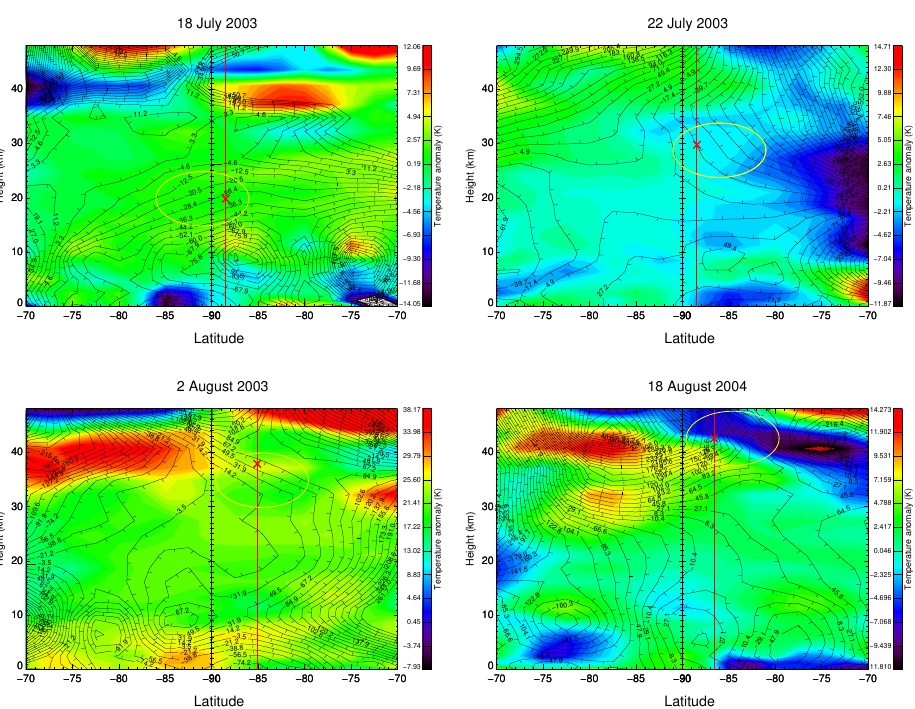
Figure 7. The 24h time-differenced contour plots of geopotential height (black contours) and temperatures obtained from ECMWF Reanal- ysis from 0 to 50km along the direction of the ray path for waves observed on 18 July 2003 (top left), 22 July 2003 (top right), 2 August 2003 (bottom left), and 18 August 2004 (bottom right), as determined by our GROGRAT model runs. Ticks on contour lines point to lower geopo- tential height. Vertical red lines mark the latitude at which the rays terminate, and the corresponding red “X” denotes the location of the wave source. The yellow oval signifies the region where we infer baroclinic